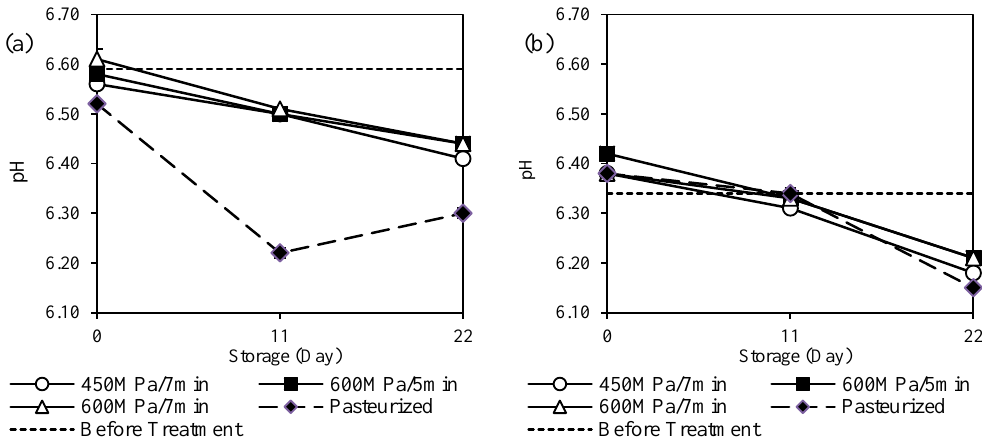
Figure 1. Changes in pH of ( a ) cow and ( b ) goat milk during storage period of 22 days. Solid lines represent HPP-treated milk (450 MPa/7 min, 600 MPa/5 min, 600 MPa/7 min), dashed lines represent pasteurized milk, and dotted lines represent fresh milk before treatment.